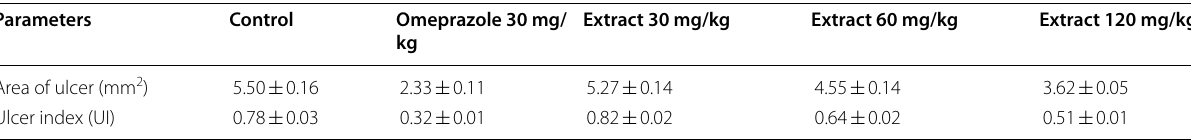
Table 1 Effect of C. zeylanica extract on area of ulcer and ulcer index in naproxen-induced acute ulcers